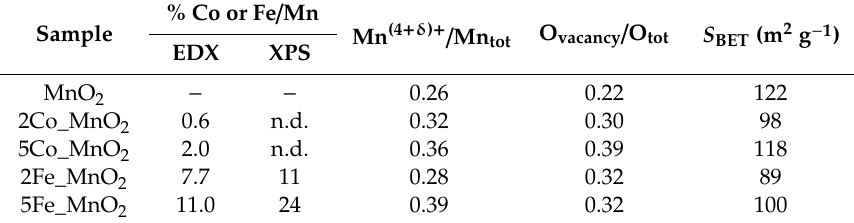
Table 2. Estimation of dopant / Mn molar ratios by energy dispersive X-ray spectroscopy (EDX) and X-ray photoelectron spectroscopy (XPS). XPS ratios between counts of Mn (4 + δ ) + (relative to Mn 2p 3 / 2 ) or oxygen vacancy (O vacancy ) peaks and total counts for all the investigated samples. BET specific surface area ( S BET ). n.d. = no data.